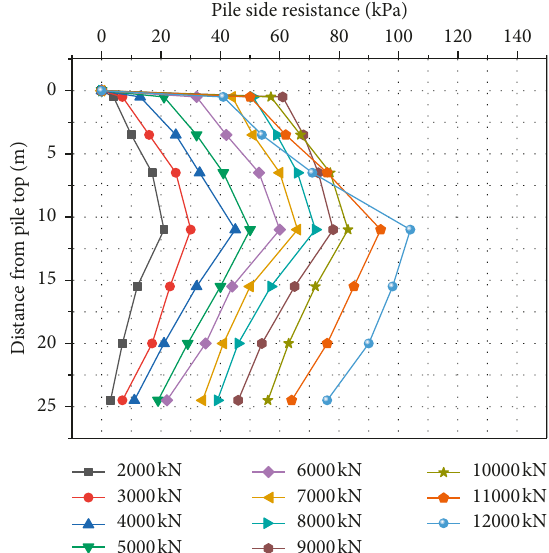
Figure 12: Pile side resistance of